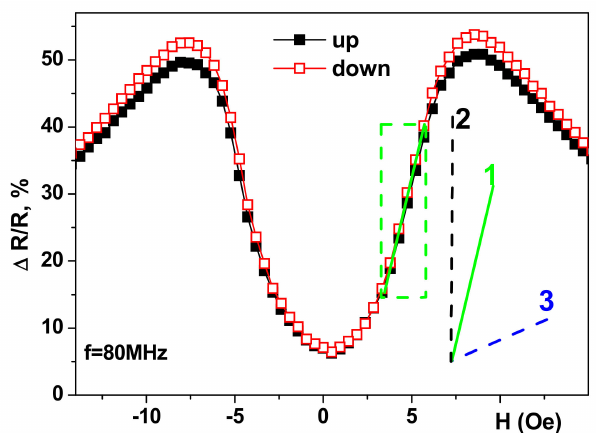
Figure 1. Field dependencies of the real part of the total impedance ratio for the frequency of 80 MHz (25 ◦ C measurements): glass/[Cu(3 nm)/FeNi (100 nm)] 5 /Cu(500 nm)/[Cu(3 nm)/FeNi(100 nm)] 5